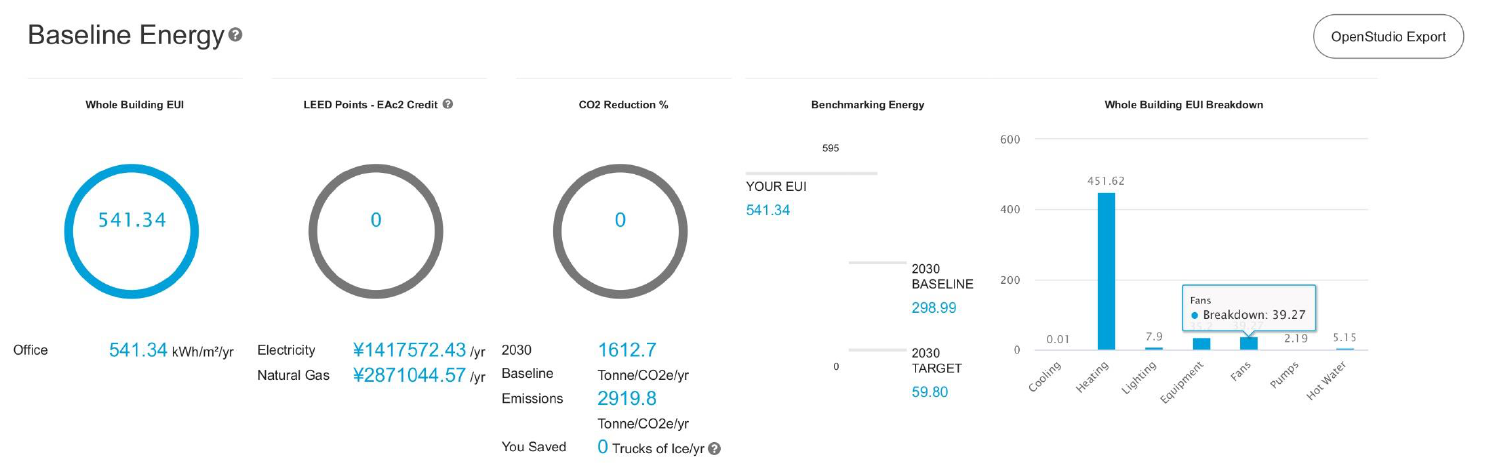
Figure A38. Zone 6-H Xi’ning, Qinghai (post-COVID-19 78% Figure A38. Zone 6- H Xi’ning, Qinghai (post-COVID-19 78% scenario).